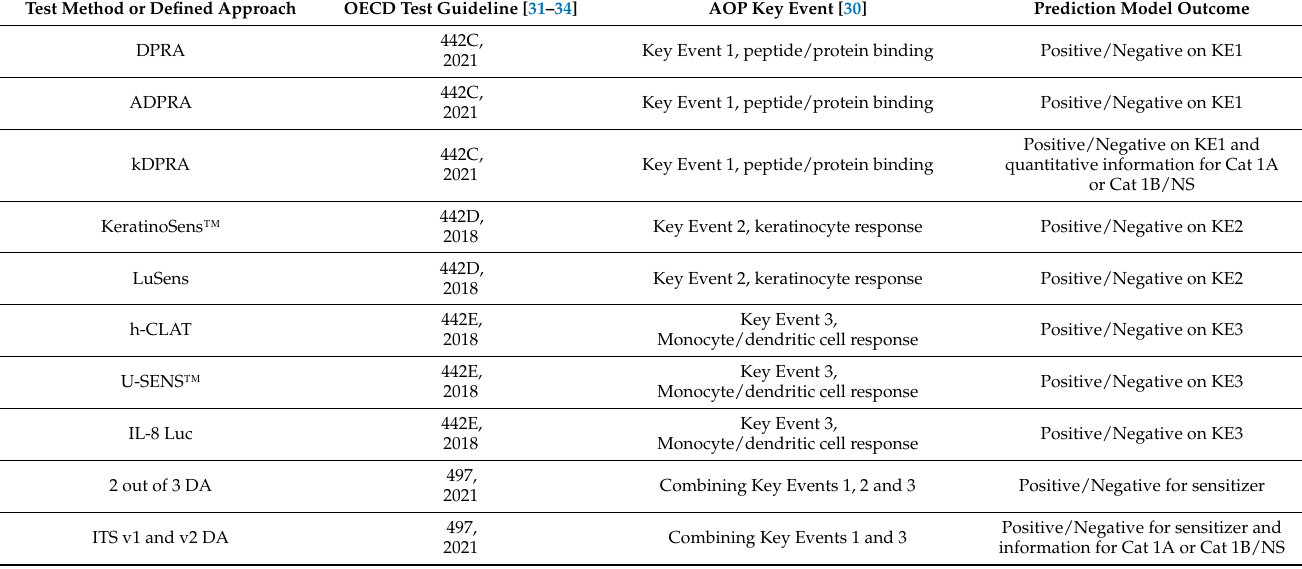
Table 1. Available New Approach Methods for Assessing Skin Sensitization